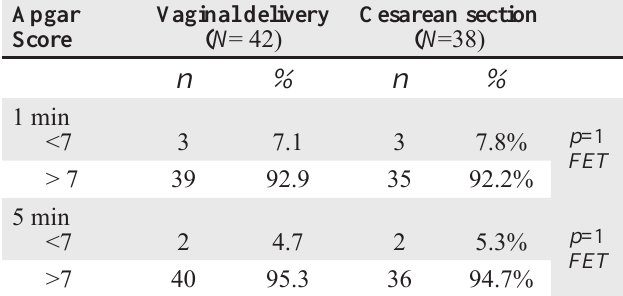
Table 1: APGAR score by mode of delivery